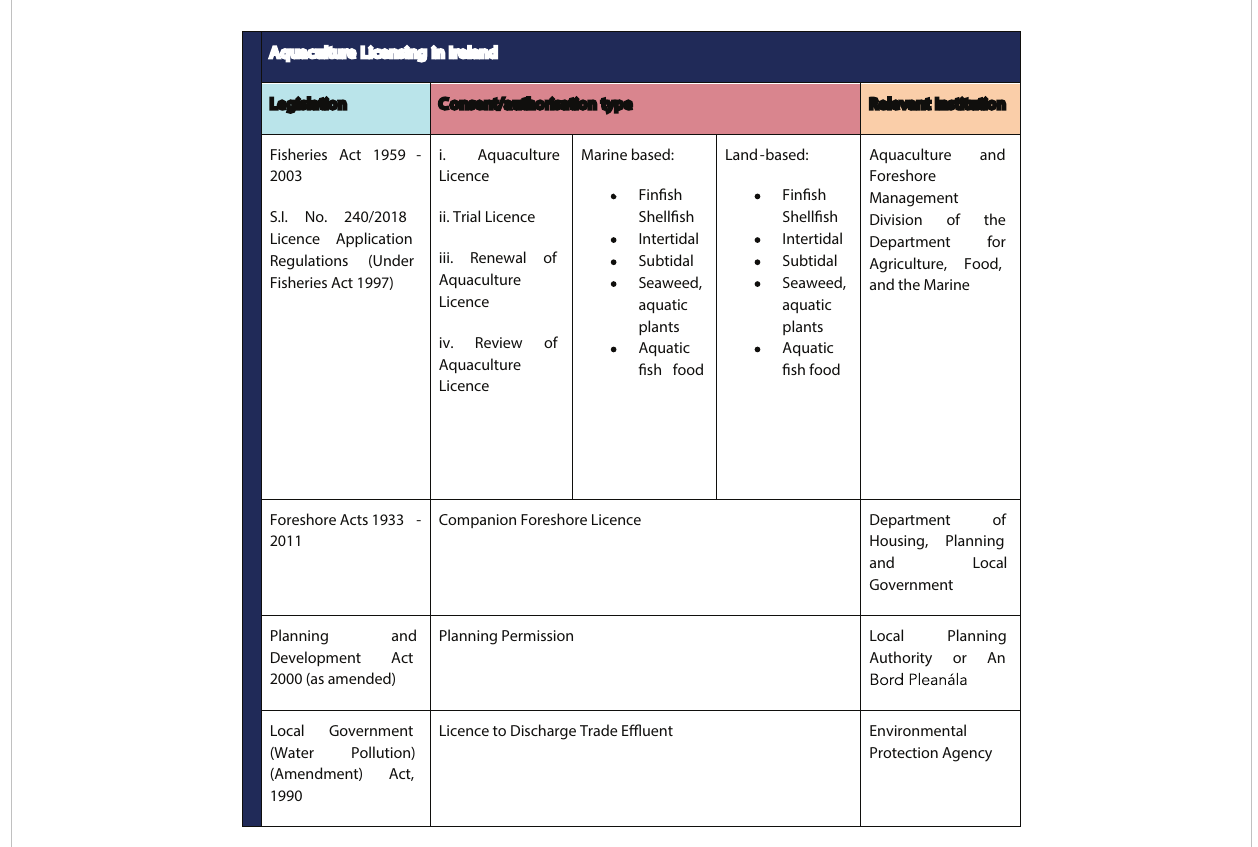
FIGURE 2 Aquaculture Licensing in